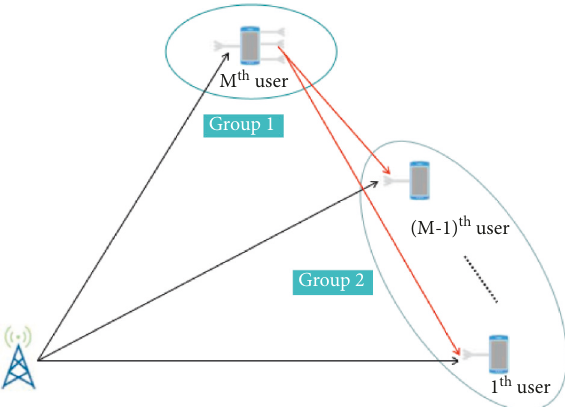
Figure 1: A downlink MISO transmission